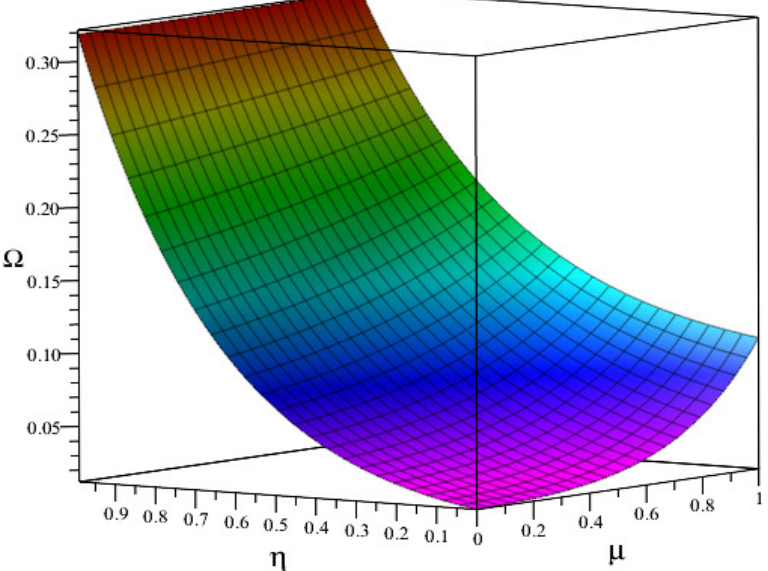
Figure 2. Representation of effect of change in µ ∈ [ 0,1 ] for different fractional order η ∈ ( 0,1 ) on stability condition Ω